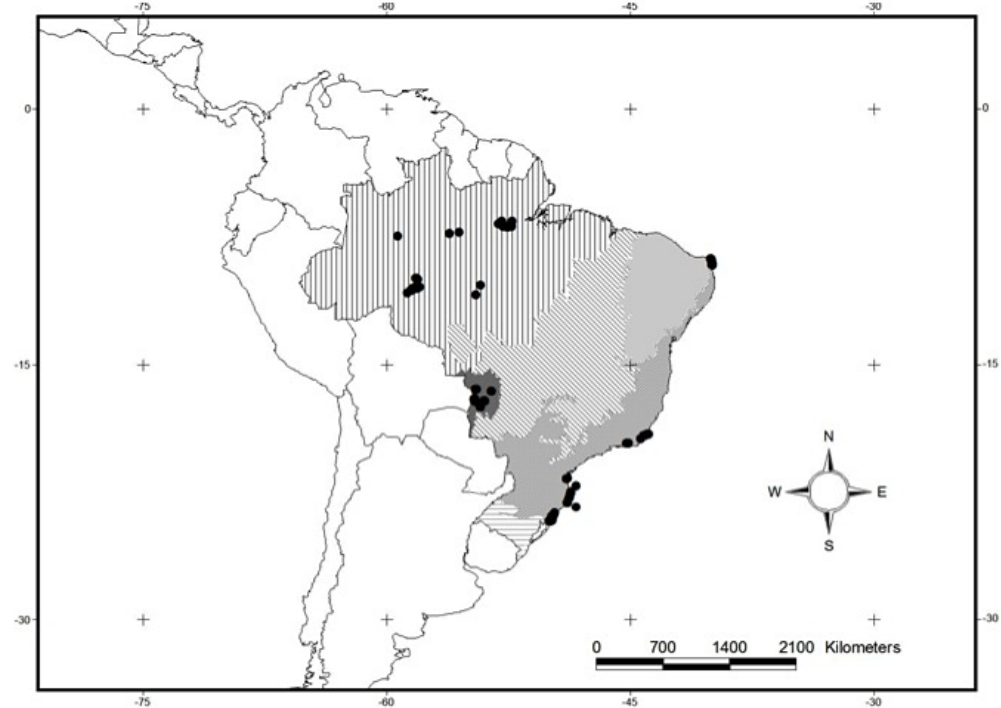
Figure 1. Geographic location of Brazilian lakes sampled in different biomes (IBGE 2004, available at ftp://geoftp.ibge.gov.br/mapas_ tematicos/mapas_murais/biomas.pdf): Amazonia forest (vertical lines), Pantanal floodplain (dark gray) and Atlantic Forest (gray; tropical and subtropical coastal